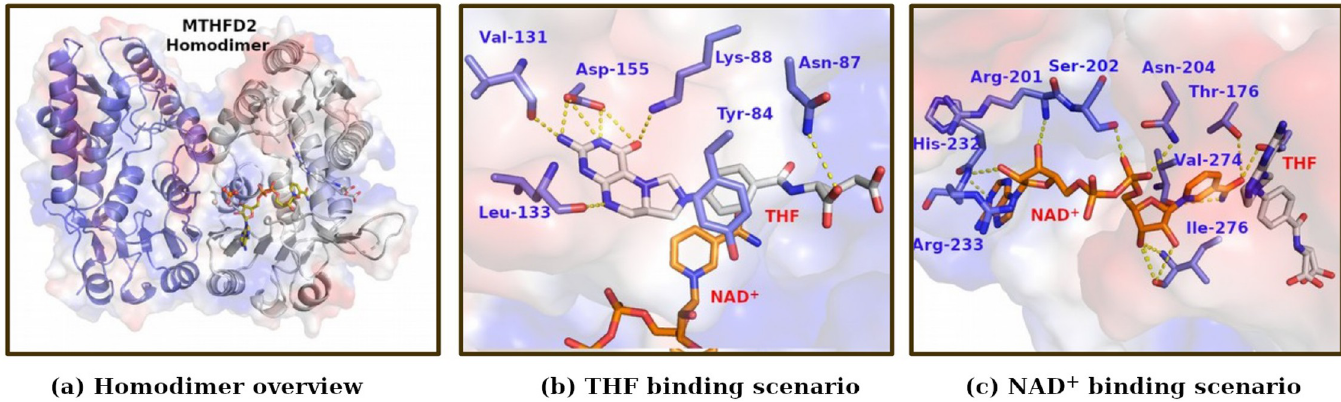
Fig 2. Overview of modeled MTHFD2 system, with THF and NAD + binding pockets. (a) Homodimer overview (b) THF binding scenario (c) NAD + binding scenario.